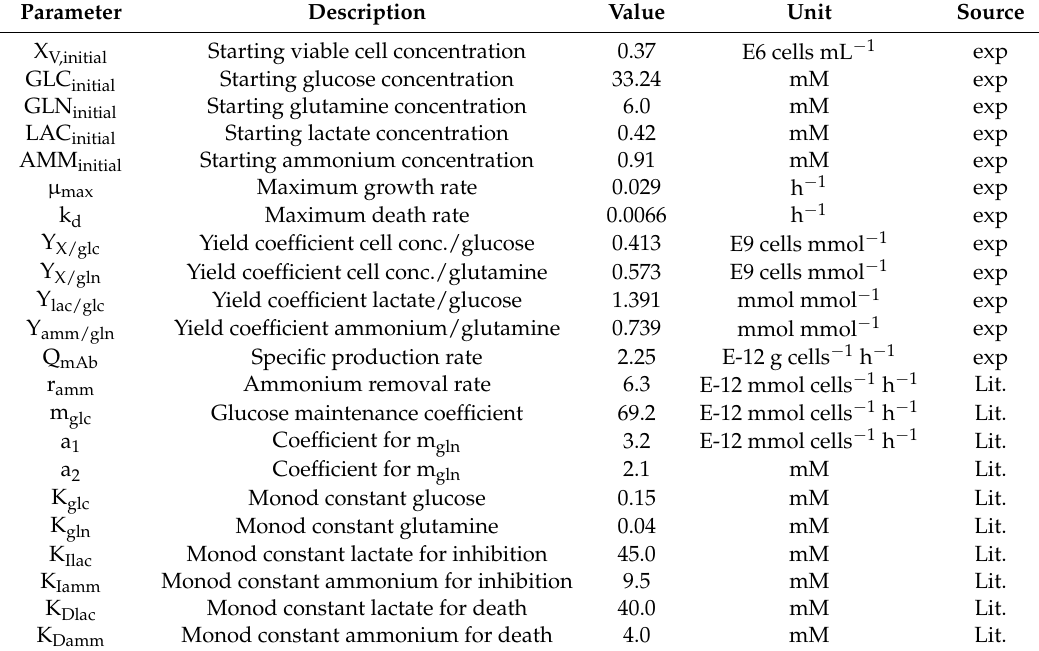
Table 2. Model parameters employed in the macroscopic kinetic model. GLC, glucose, GLN, glutamine; LAC, lactate; AMM,